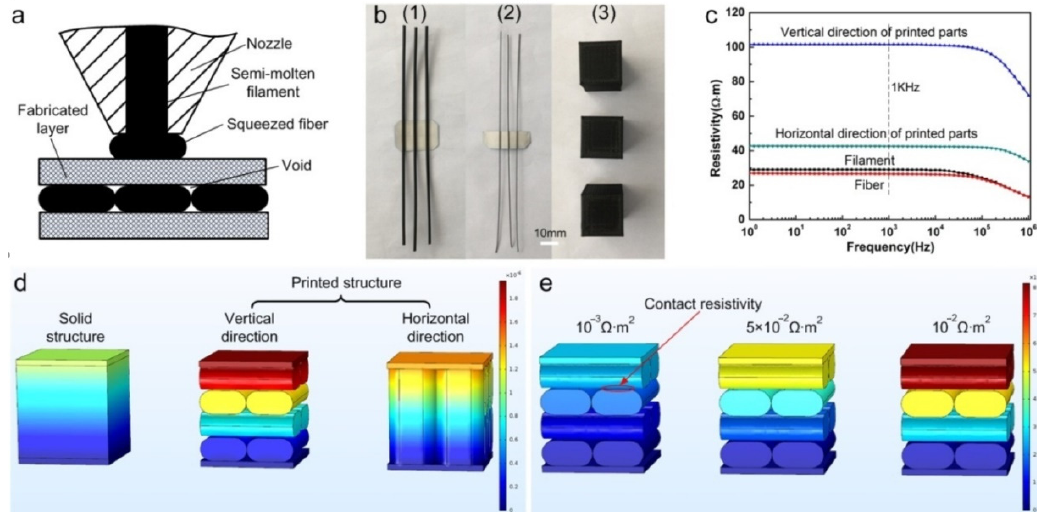
Figure 4. Different shapes and their resistivities for materials printed with the FDM method: ( a ) FDM printing process; ( b ) different materials shapes: filament, fibre, and cube; ( c ) resistivities of materials printed in different build orientations and frequencies of 1 Hz–1 MHz; ( d ) different structures of samples: solid, vertical direction and horizontal direction and ( e ) resistivities of the printed structure models in the vertical direction. Adapted with permission from Ref. [38]. 2017,